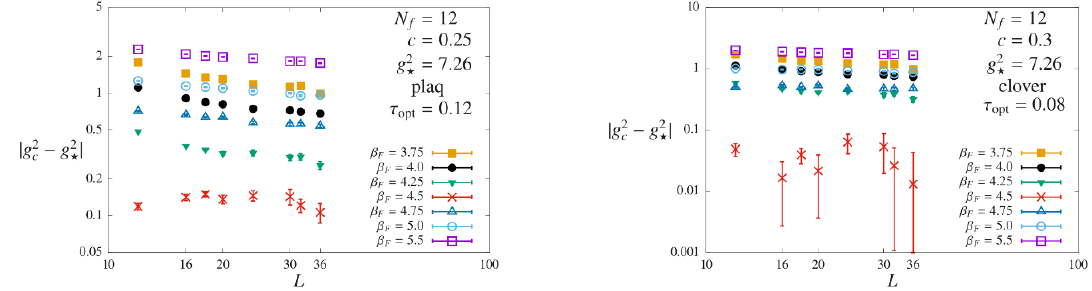
Figure 6 . Raw data for (cid:12)nite-size scaling analyses of the critical exponent (cid:13) ? in eq. (5.3) corresponds to straight lines on these log-log plots of j plaquette discretization of E ( t ) at c = 0 : 25 (left, with (cid:28) (plaq) c = 0 : 3 (right, with (cid:28) opt = 0 : 08) we see from (cid:12) F = 5 : 5 to 4.75 (empty symbols), then move to even stronger renormalized couplings for 4 : 25 (cid:20) (cid:12) F (cid:20) 3 : 75 ((cid:12)lled symbols). Around (cid:12) F (cid:25) 4 : 5 the signal e(cid:11)ectively vanishes since